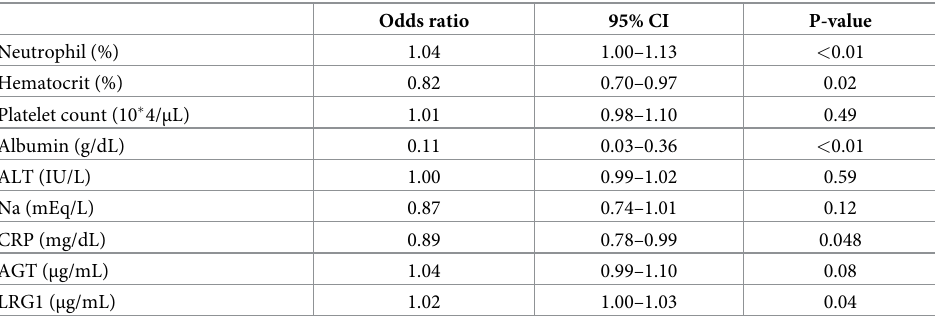
Table 2. Multivariable analysis of laboratory data for diagnosis of